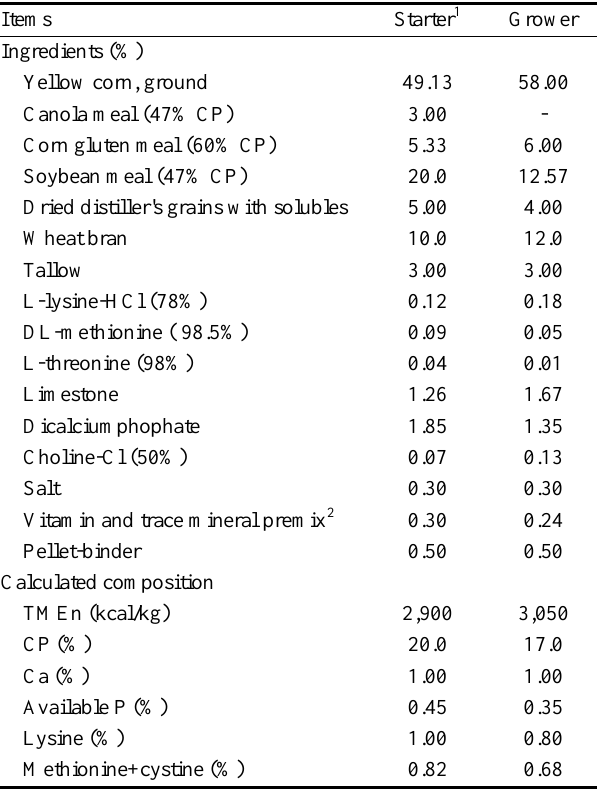
Table 1. Ingredients and chemical compositions of the experimental diets, as-fed basis Items Starter 1 Grower Ingredients (%) Yellow corn,